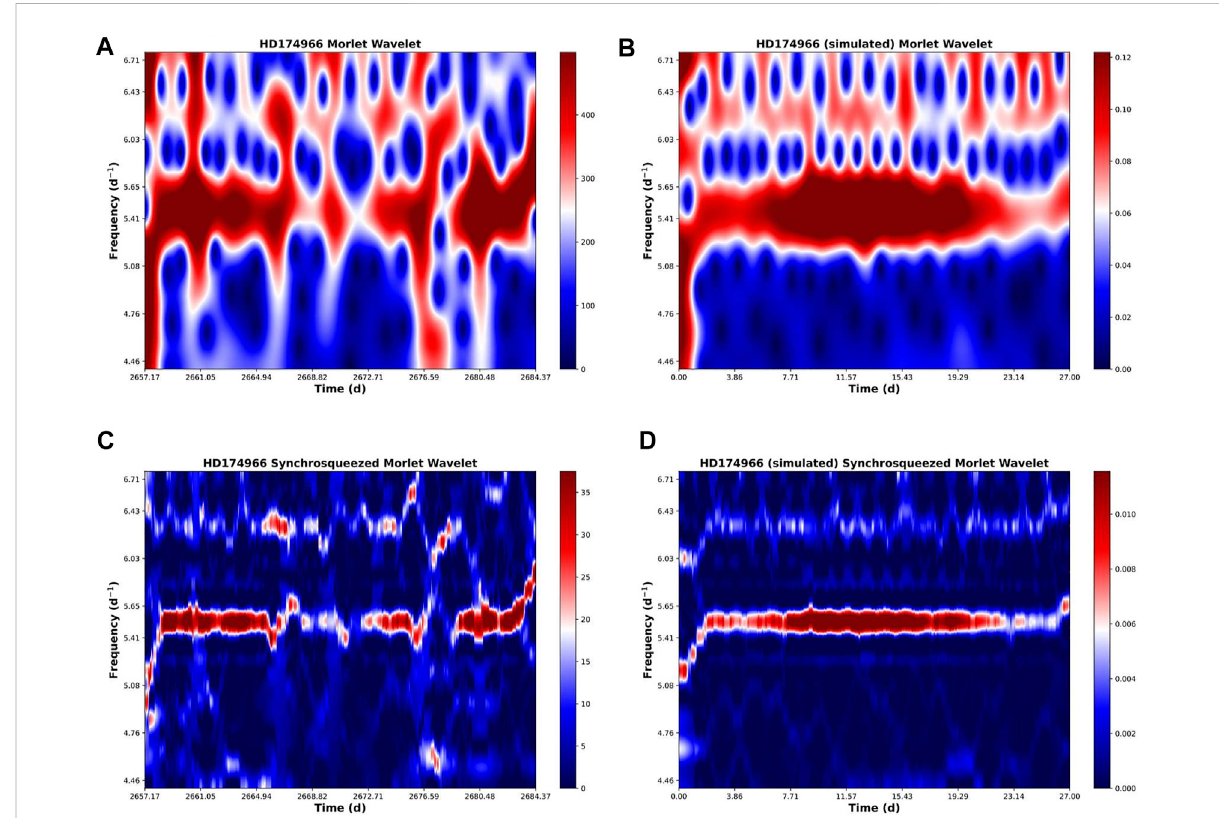
FIGURE 4 Frequencies of HD174966 between 4.46 d − 1 and 6.71 d − 1 . The frequency at 5.51 d − 1 shows a clearly different behaviour in the signal (A,C) comparedtothesyntheticcurve (B,D) .TheSSWCTofthesyntheticcurveshowsauniformband,apartfromthebordereffect,whereastheSSWCTof the light curve suffers an interruption at about 2666 d , then is resumed at 2672 d and then stoppedagain at2677 d before fi nally resuming at 2678 d . The other frequency at about 6.3 d − 1 seems to be reacting in an opposite way. This behaviour maybe due to an interaction between these two frequencies but could also be due to a transient of some kind or a magnetic fi eld